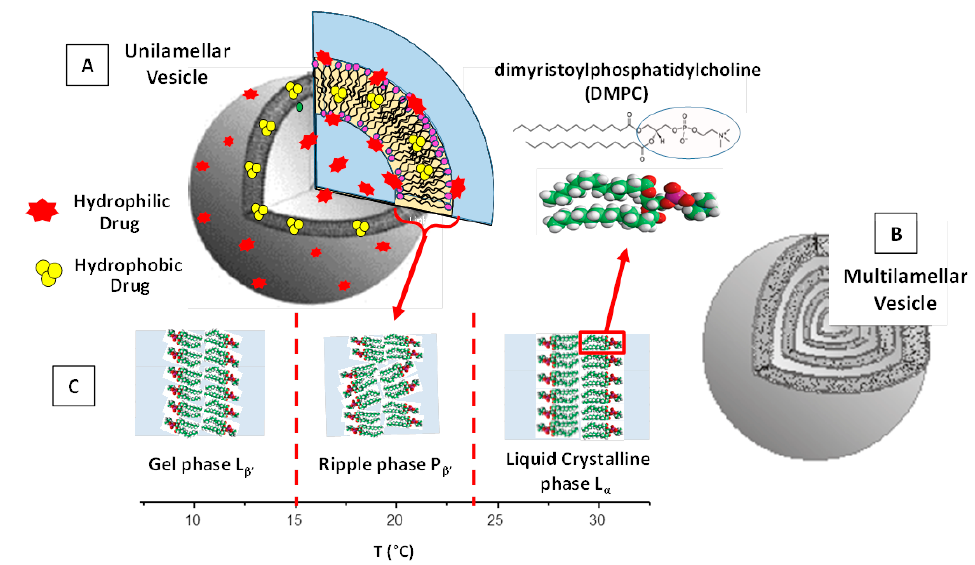
Figure 1. Schematic representation a DMPC unilamellar liposome ( A ). Typical onion-like structure composed of concentric bilayer surfaces (hydrated multilayers) of a multilamellar vesicle (MLV) ( B ). Characteristic phases of a water solution of DMPC phospholipids ( C ).